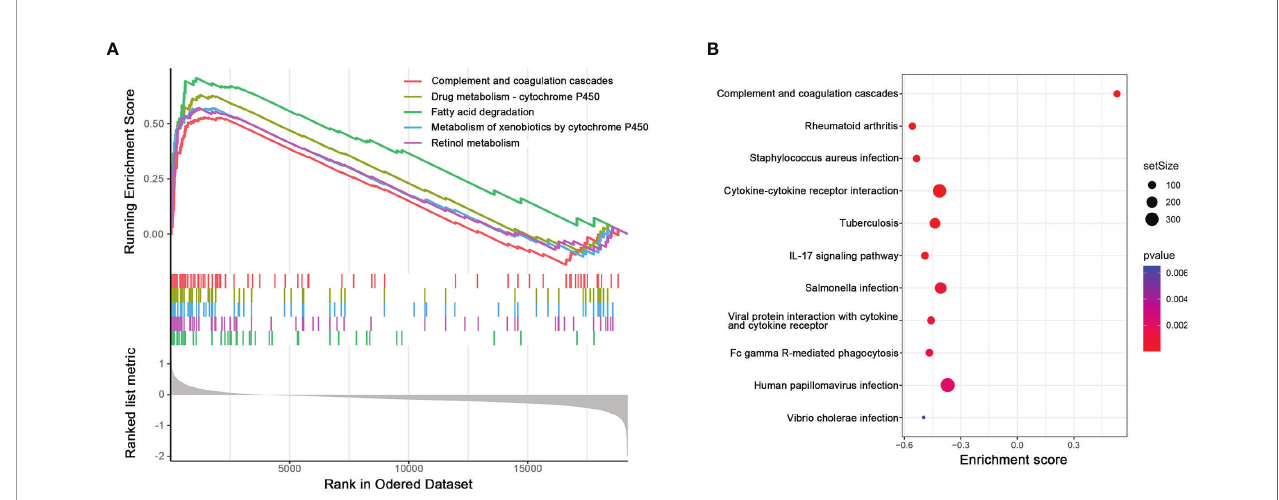
FIGURE 4 | (A) Potential pathways related to high pIRS scores based on GSEA. (B) Immune-related pathways among GSEA KEGG